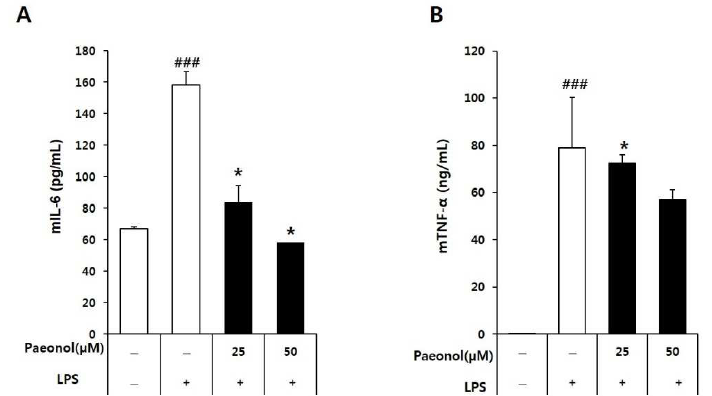
Figure 5. Effect of paeonol on the pro-inflammatory cytokines IL-6 ( A ) and TNF-α ( B ) in LPS-acti-